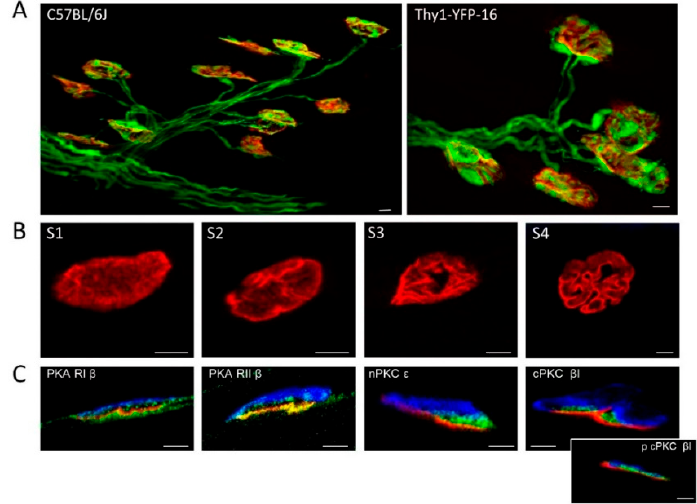
Figure 1. Postnatal polyneuronal innervation in the neuromuscular junctions (NMJ). In ( A ) , representative confocal images showing several NMJs at postnatal day 9 with different degrees of polyinnervation from C57BL/J6 mice (left, axons stained with anti neurofilament fluorescent antibody) and Thy-1-YFP-16 mice (right, autofluorescent axons). ( B ) shows the morphological maturation stages (S1–S4) of the postsynaptic nAChR clusters. In ( C ) , are semithin sections that show the presence of protein kinase A (PKA) regulatory subunits (RI β and RII β ), and nPKC ε and cPKC β I (the inset shows phospho cPKC β I) isoforms in the NMJ (green). S-100 in (blue). In all cases, nAChRs are stained with tetramethylrhodamine conjugated α -bungarotoxin (red). The bars indicate 10 μ m.